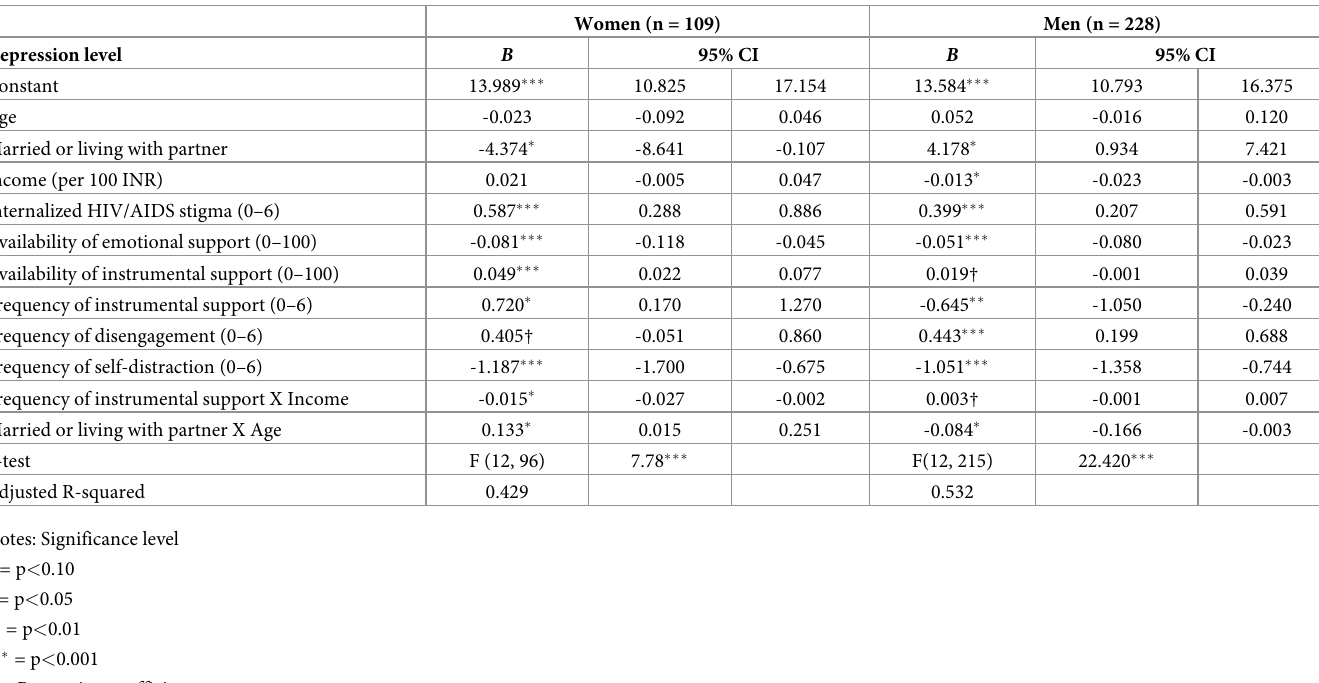
Table 3. Unstandardized multiple linear regression coefficients and 95% confidence intervals for correlates of depression severity among people living with HIV in India, stratified by gender (n =